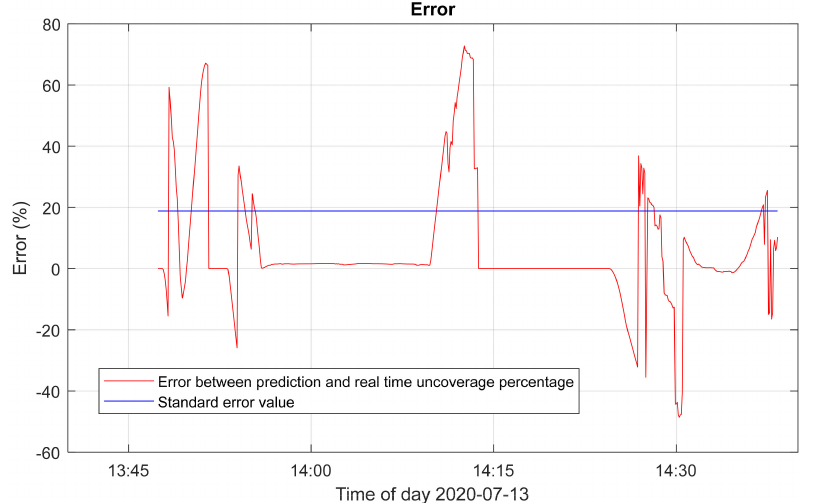
Figure 13. Error level between real-time and predicted level of sun un-coverage on 13 July 2020 from 13:45 to